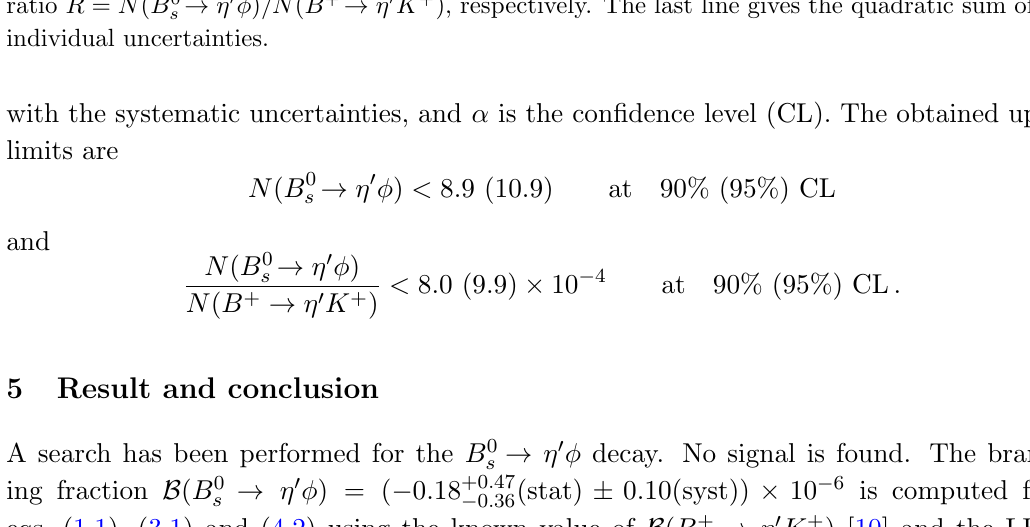
(cid:17) 0 (cid:30) ) and on the yield s !